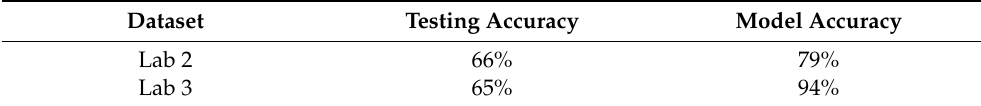
Table 3. Accuracies of the Lab 1 model (DenseNet201) on the Lab 2 and Lab 3 datasets, and model building using the Lab 2 and Lab 3 dataset.